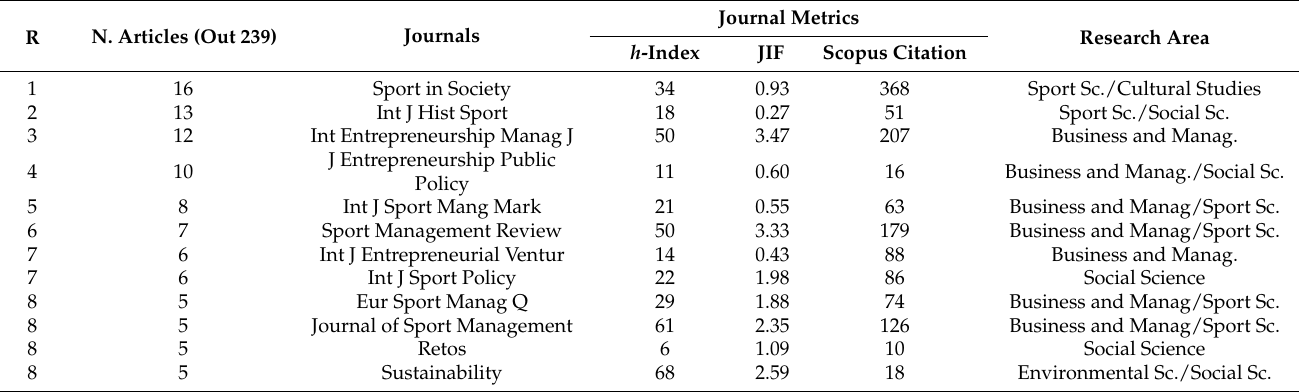
Table 1. Scientific journals with the greatest number of articles published.